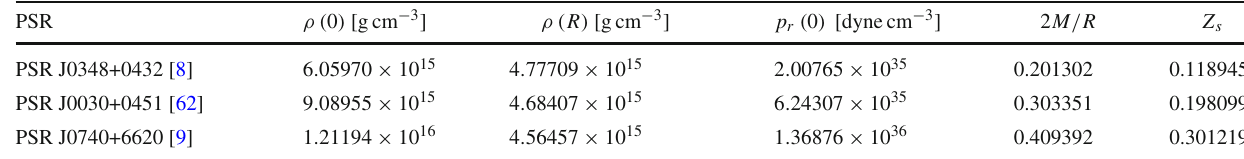
Fig. 5 Behaviour of the M − ρ c and M – R diagrams of our stellar model for three heavy pulsars. For plotting these graphs, we use the numerical values of the constant parameters given in Table 1 Table 2 Some physical parameters calculated for radii and mass for some heavy